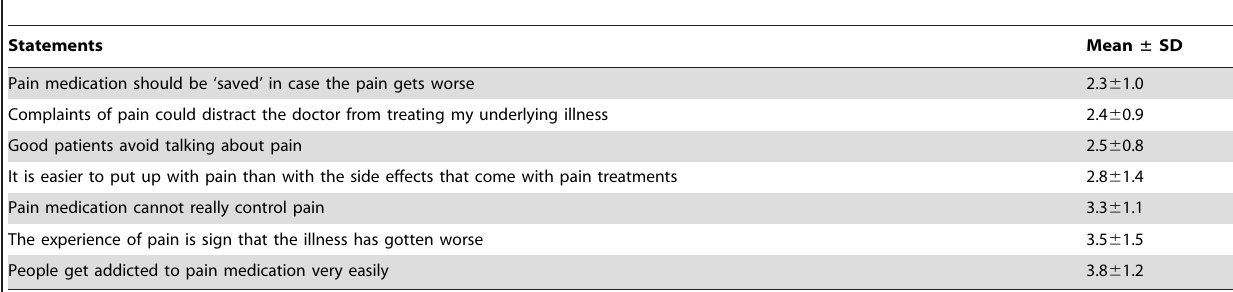
Table 2. Patients’ agreement with barrier statements, sorted in increasing